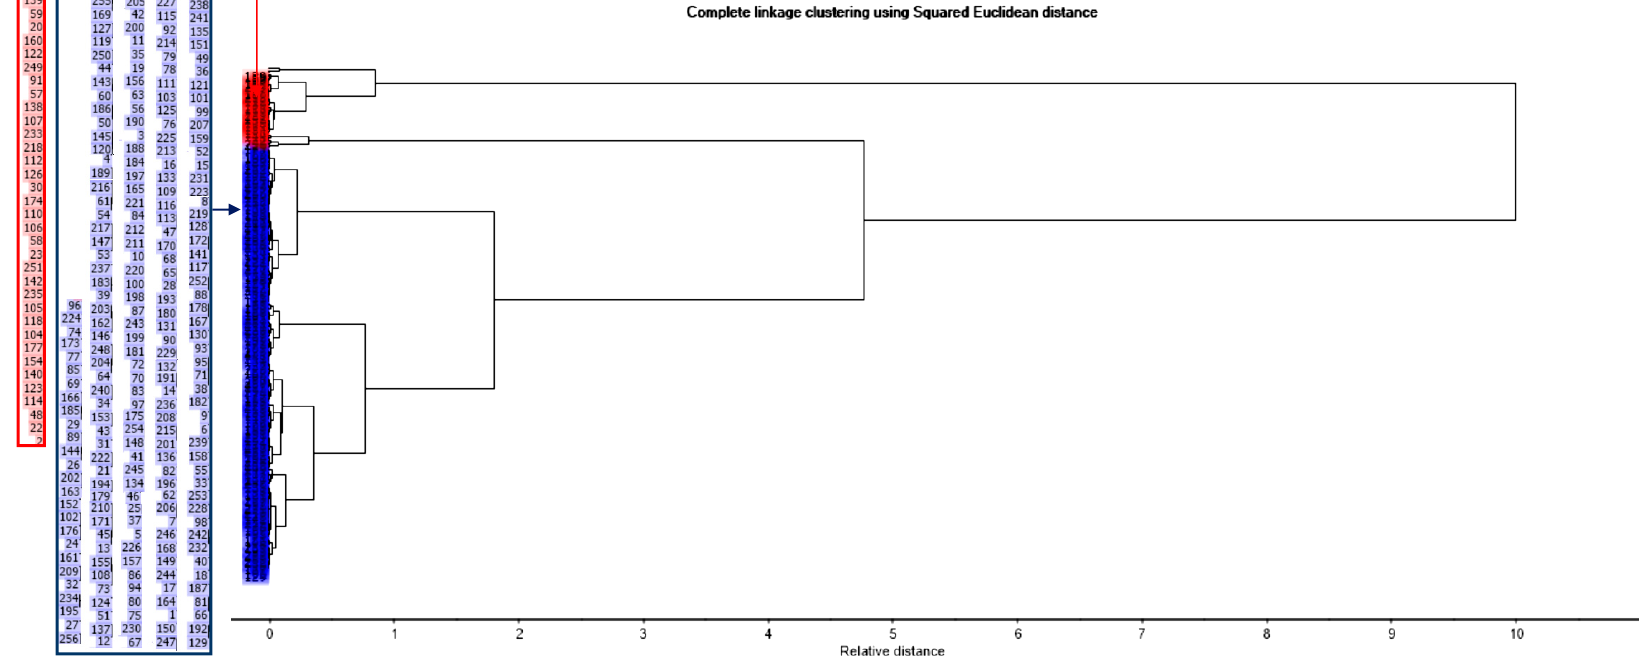
Figure 6. Dendrogram plot acquired during the cluster analysis based on the scores of PLS (the samples, highlighted with the red and blue rectangles, make up the red and blue clusters of the dendrogram, respectively; the samples are located on the y-axis of the dendrogram in the same order as in the columns in the rectangles).